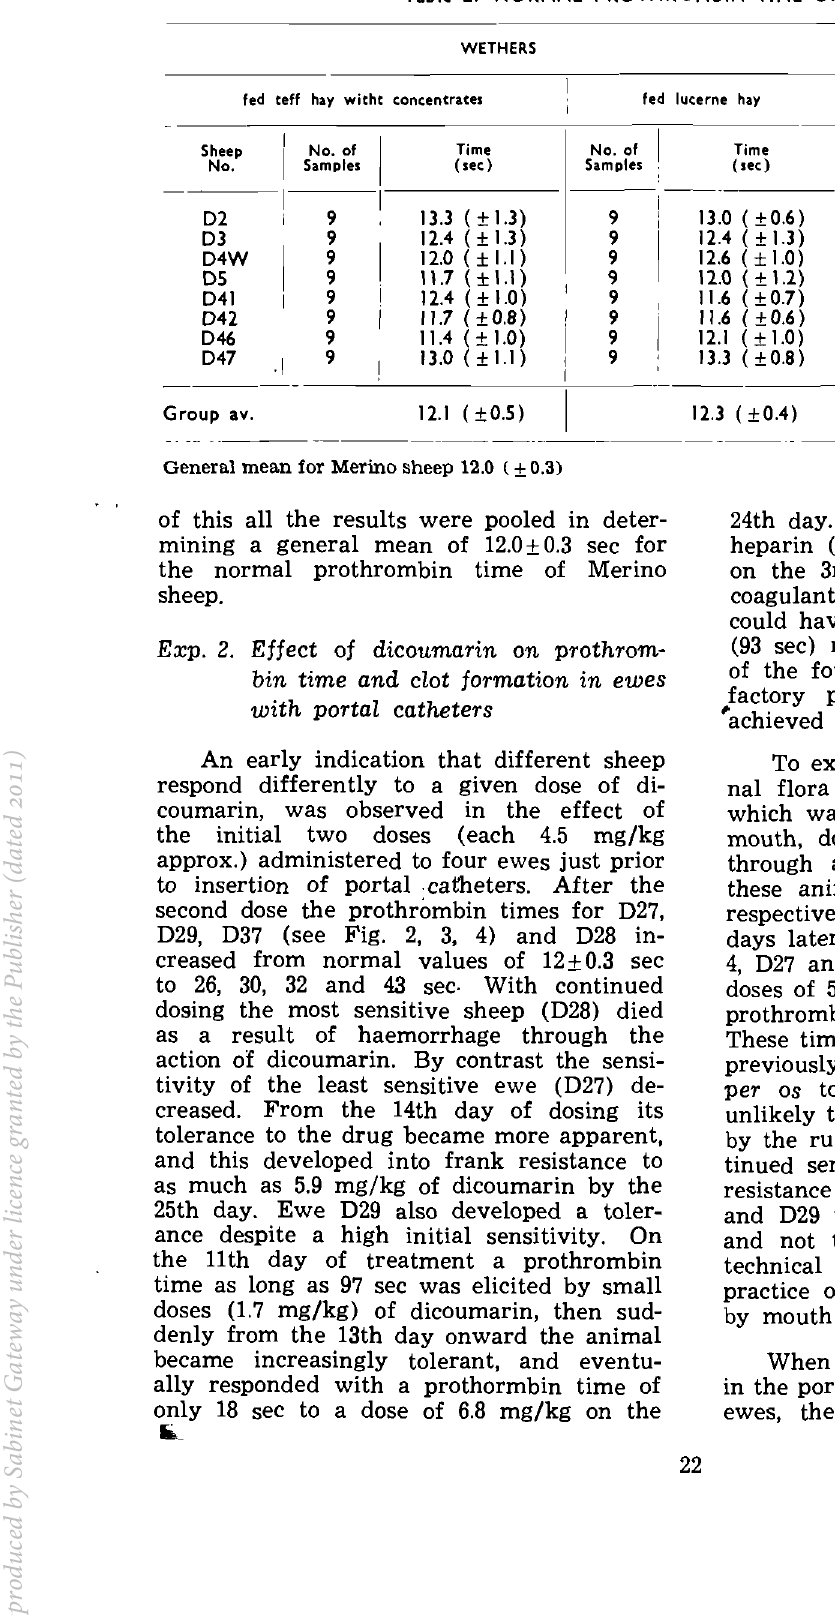
Table 2: NORMAL PROTHROMBIN TIME OF MERINO SHEEP